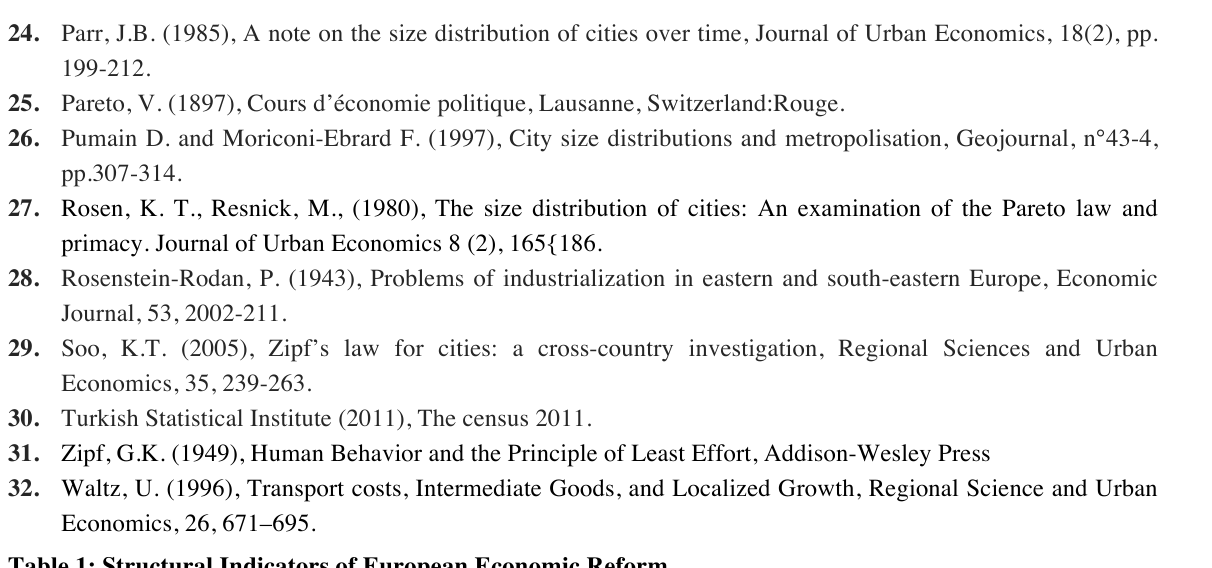
Table 1: Structural Indicators of European Economic Reform 1. Headline